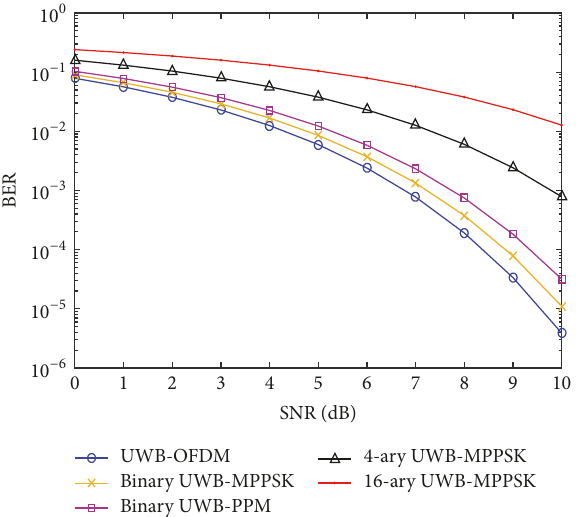
Figure 9: Comparative SER results of UWB-OFDM, Binary UWB- MPPSK, 4-ary UWB-MPPSK, and 16-ary UWB-MPPSK.